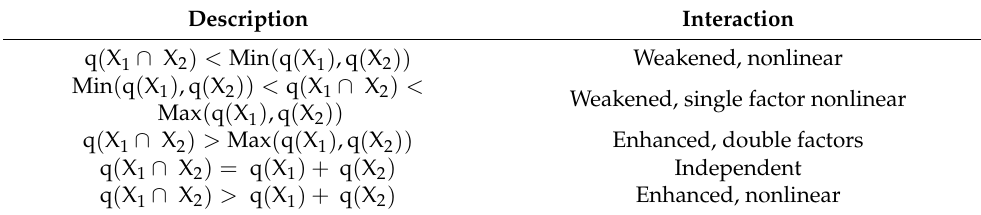
Table 4. The interactive relationships in the